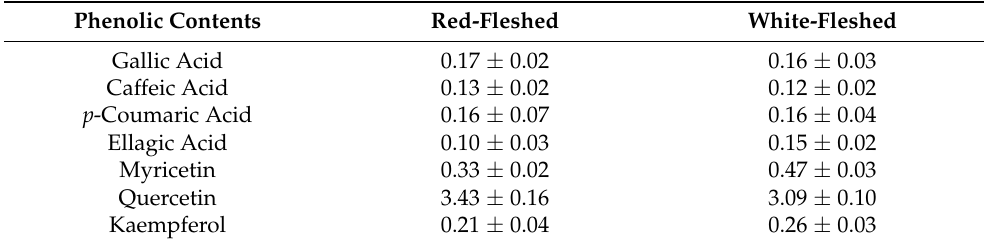
Table 2. Phenolic contents of two pitaya species ( Hylocereus spp.) (mg/100 g).